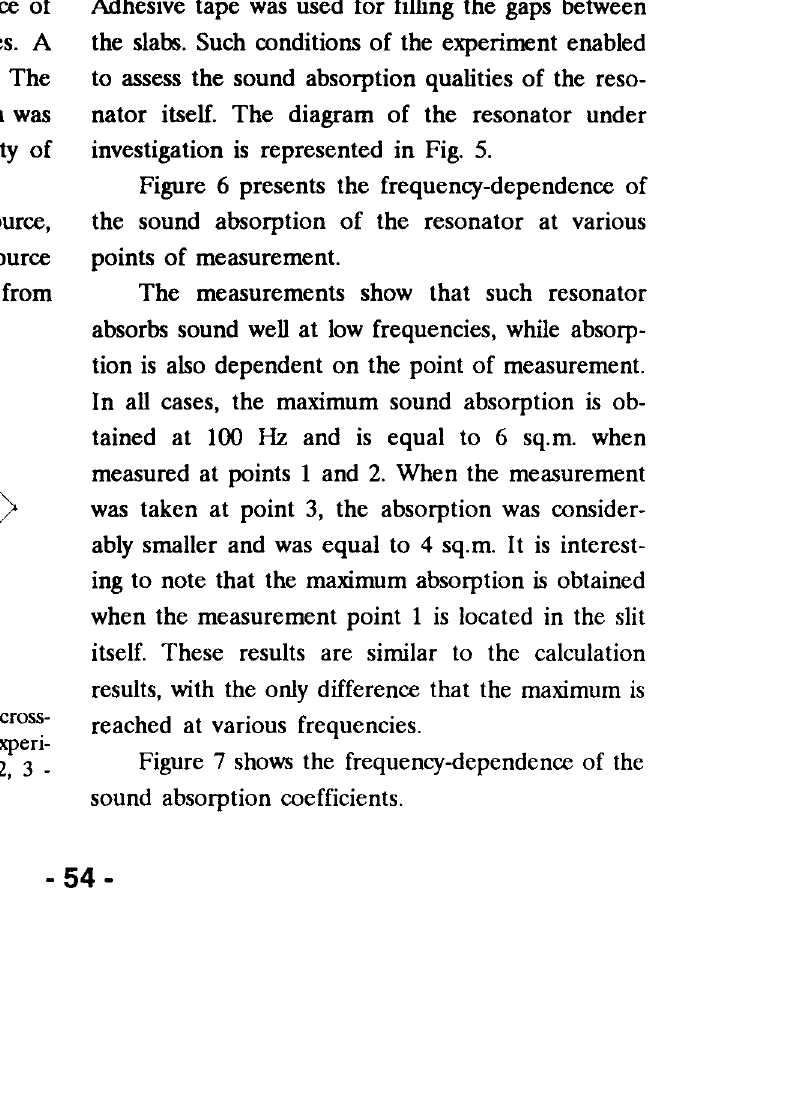
Fig. 4. The dependence of the imaginary parts of the cross-shaped resonator on the number of resonators. 1, 2, 4, 6 and 8 - 1, 2, 4, 6 and 8 resonators, respectively